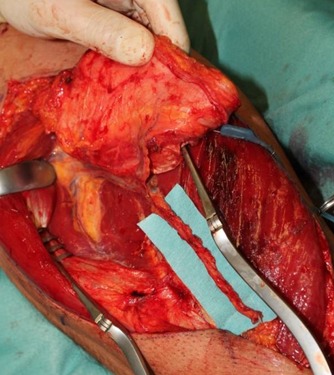
Harvested ALT flap